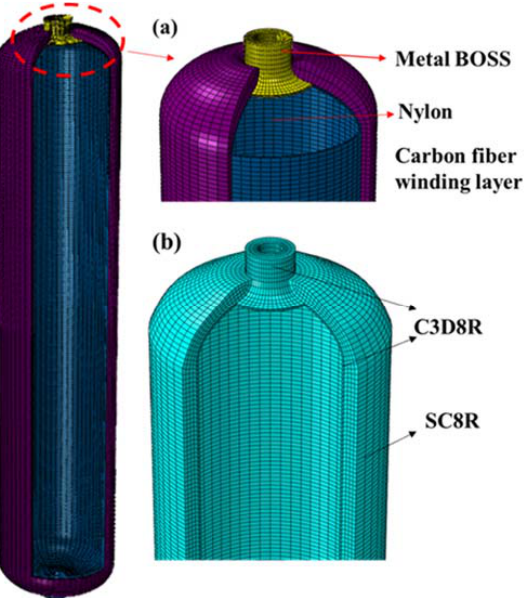
Figure 1. ( a ) Schematic diagram of the overall structure of the gas cylinder; ( b ) gas cylinder meshing.